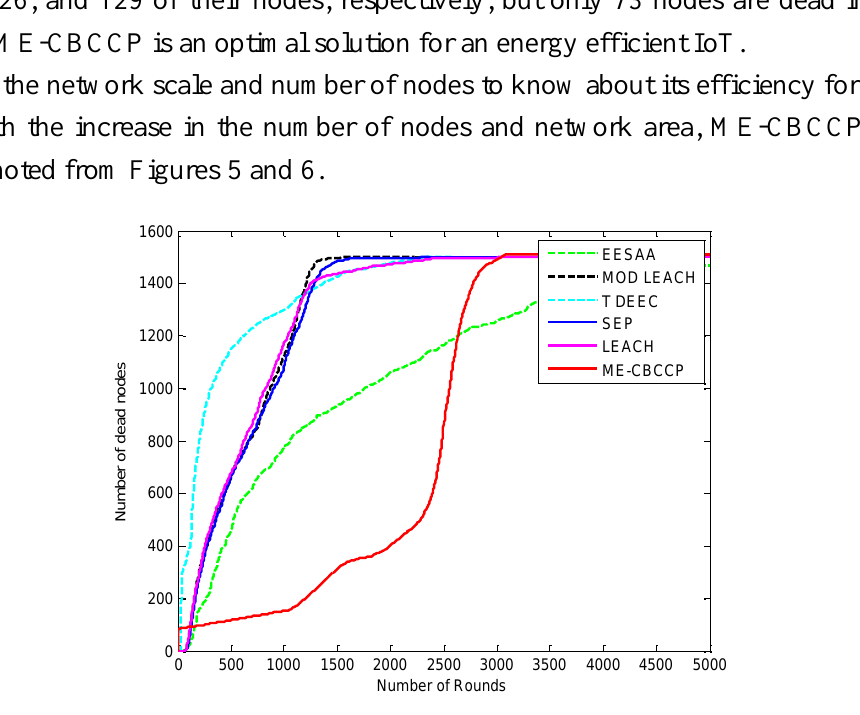
Figure 5. Network lifetime comparison (1500 nodes, with the help of alive nodes in 300 m 2